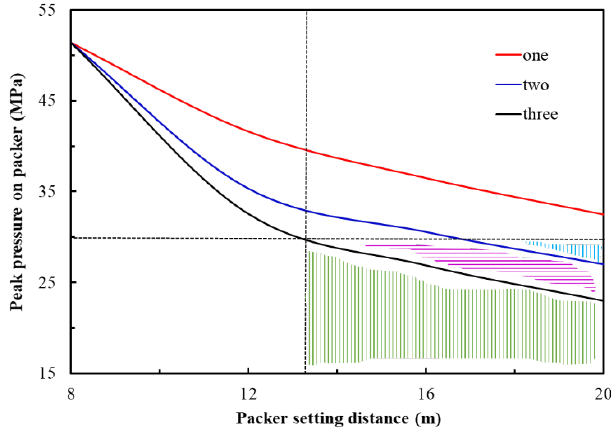
Figure 15. Safety optimization scheme.